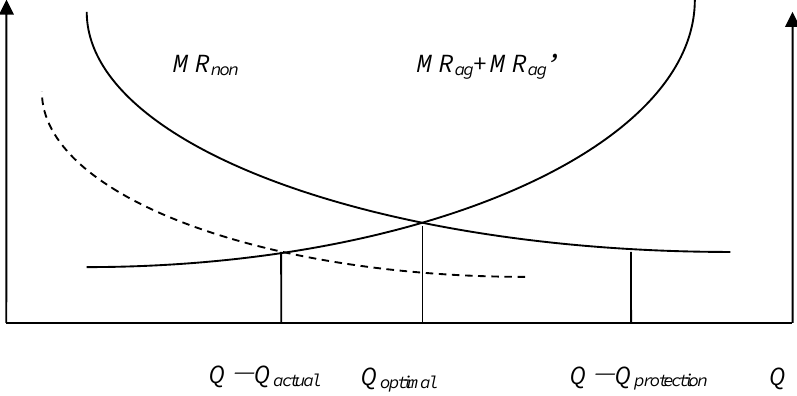
Figure 4. Allocation of county-level land resources under the fourth situation.